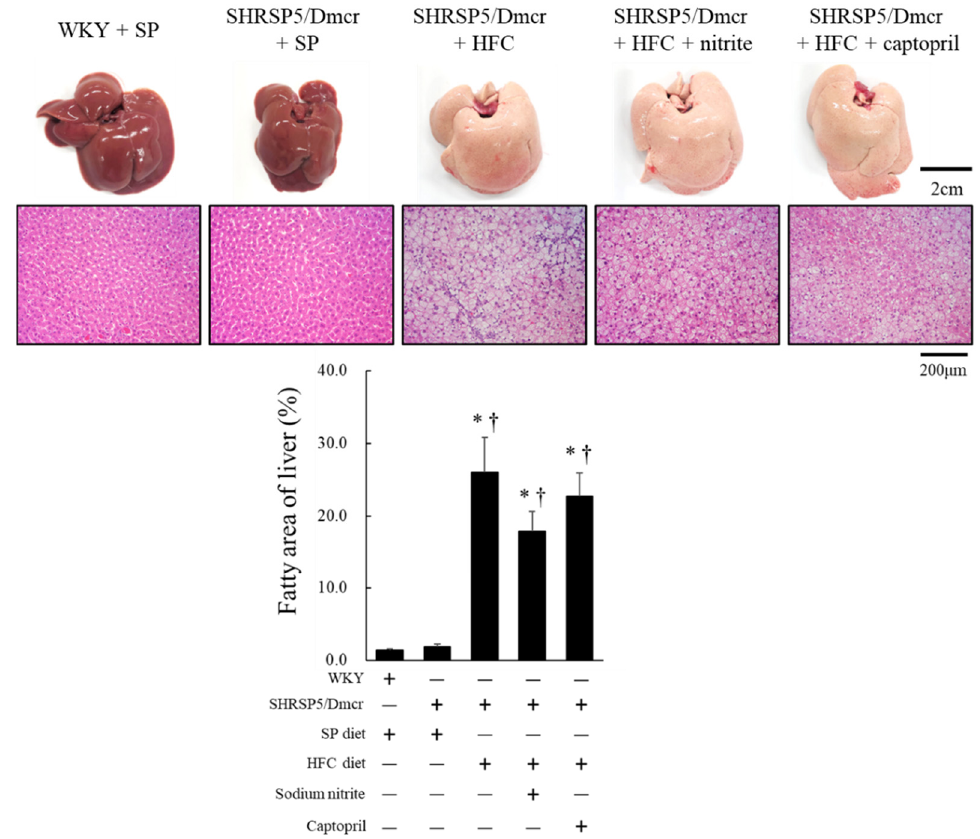
Figure 3. Macroscopic appearance and histological analysis (HE staining) of liver in WKY and SHRSP5/Dmcr rats fed SP diets and nonalcoholic steatohepatitis model rats treated with or without nitrite and captopril. Values represent mean ± SE ( n = 6), * p < 0.05, vs. the WKY + SP diet group, † p < 0.05, vs. the SHRSP5/Dmcr + SP diet group.